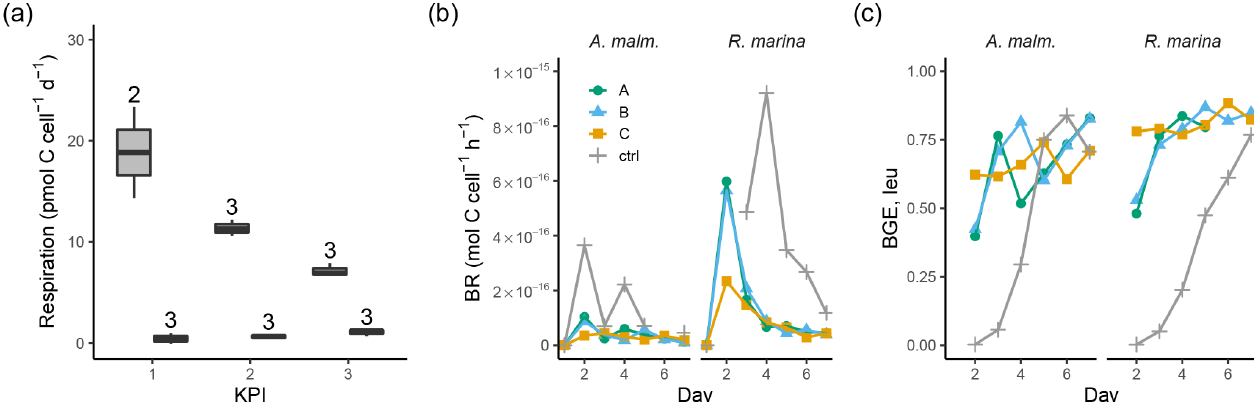
Figure 5. (a) Community respiration divided by phytoplankton abundance in A. malmogiense treatments (grey, left) and R. marina treatments (white, right) at each KPI in the DOM release experiment. Cell-specific BR (b) and BGE calculated from leucine incorporation-based BP (c) in the DOM consumption experiment. Lines A, B, and C mark different replicates (culture filtrate + seawater bacteria), and ctrl marks the control (F/2 + seawater bacteria). The number above the boxplots shows the number of measurements. Lower and upper hinges of boxes mark the first and third quartiles, respectively, while the whiskers extend to the lowest and the highest values within 1.5 times the interquartile range. Table 2. Flow of 14 C originating from 14 C-NaHCO 3 between different phases of the C cycle. Numbers are percentages of 14 C accumulation rates between the phases indicated in the left column (PP:DIC is an exception as PP is a rate but DIC is a concentration). Stars indicate the significance ( p values) at the side of the significantly higher percentage between species at the corresponding KPI, compared with Welch’s ANOVA ( ∗∗∗ < 0 . 001, ∗∗ < 0 . 01, ∗ < 0 . 05). Welch ANOVA results are presented in Table B2.